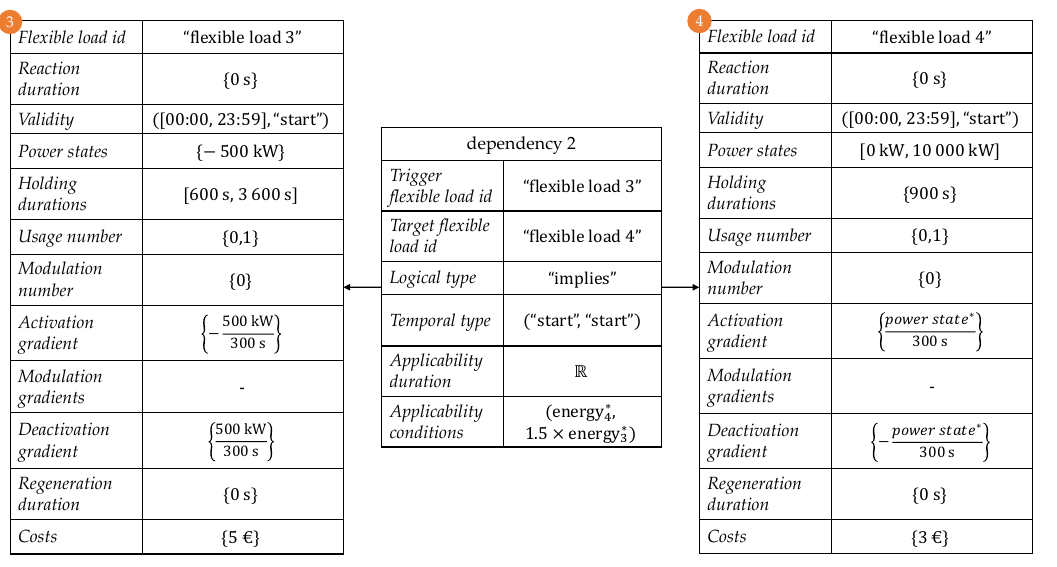
Figure 8. The data model for flexible load 3 and flexible load 4.